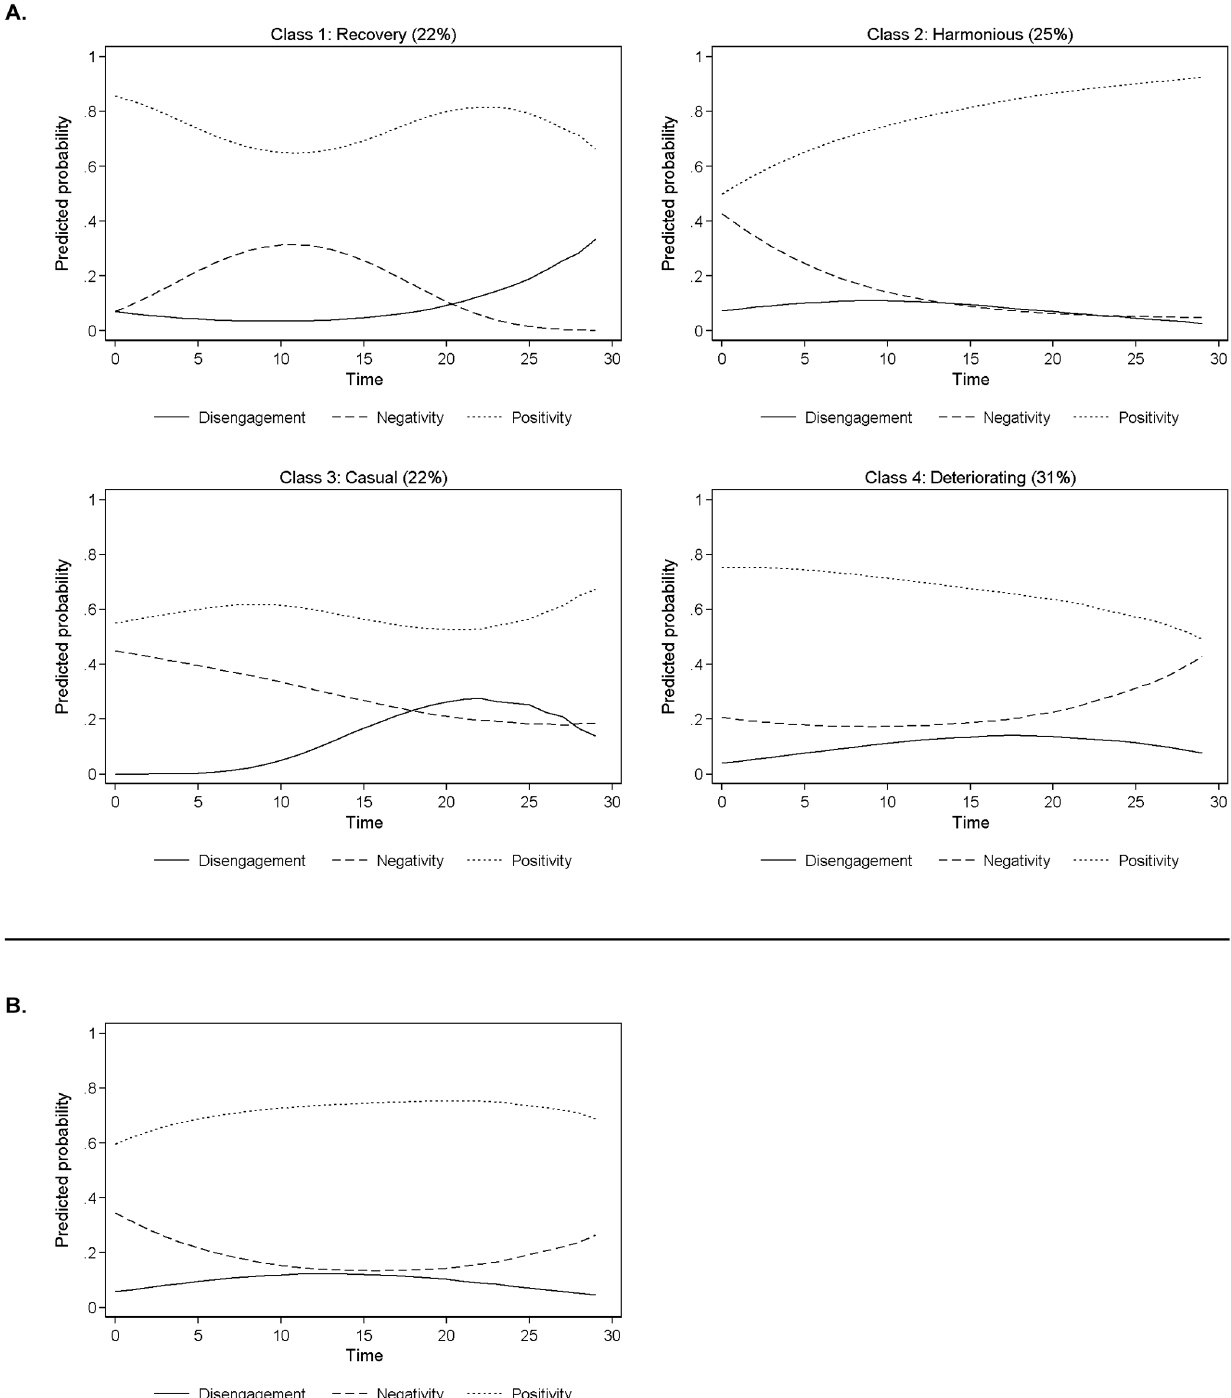
Fig 2. Average predicted probability of temporal behavioral sequences from the 4-class model for older children (A) and Class 2 of the rejected 3-class model for older siblings (B).